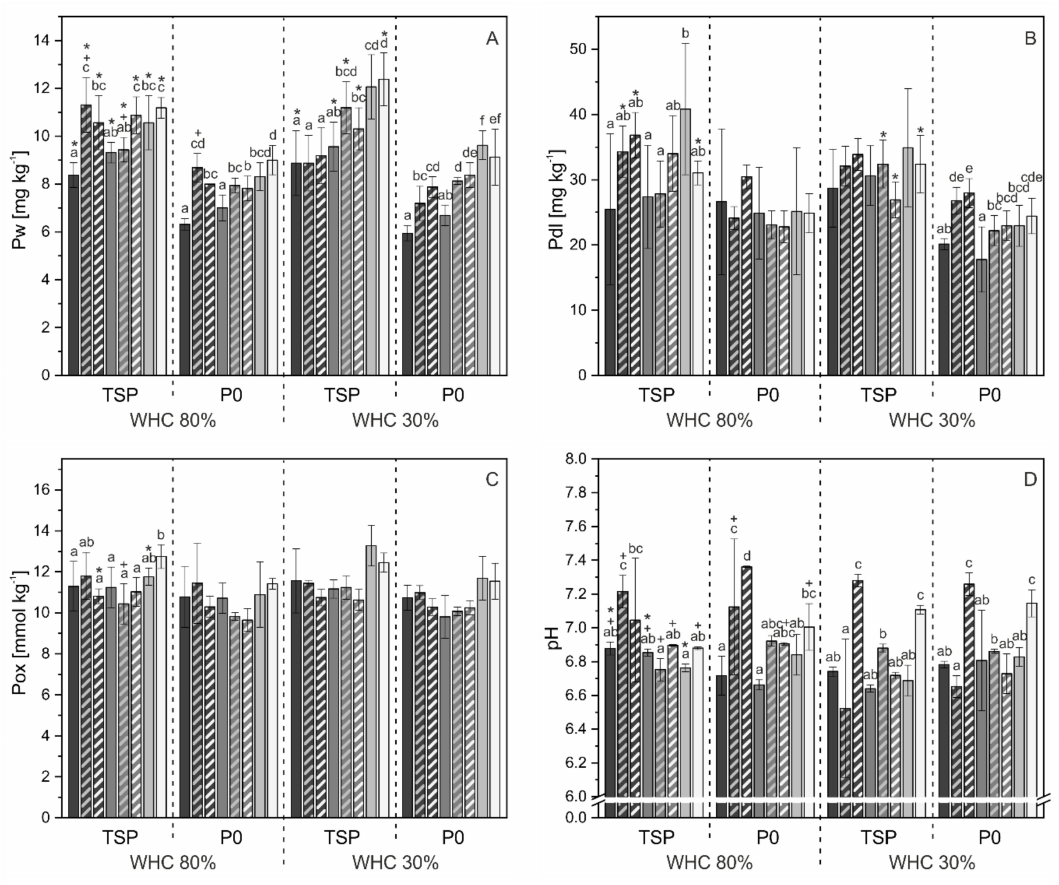
Figure 8. E ff ect of water supply, phosphorus supply and crops on water-extractable phosphorus (Pw, A ), double lactate-extractable phosphorus (Pdl, B ), oxalate-soluble phosphorus (Pox, C ) and pH ( D ) in soil after harvest in the Water-P-Trial (mean ± SD). Di ff erent letters indicate significant di ff erences between the crop variants at each water and P level, + indicates di ff erences between the water levels, * indicates di ff erences between the P levels (ANOVA and Duncan’s test, p ≤ 0.05). WHC = water holding capacity, TSP = triple-super P, P0 = control without